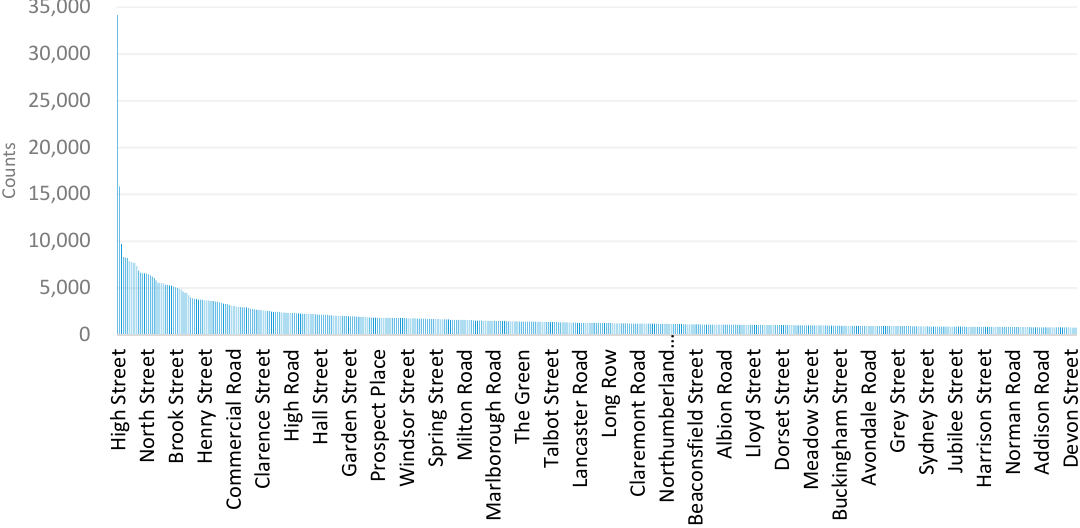
Figure 1. Frequency distribution of the 500 most frequently occurring street names.